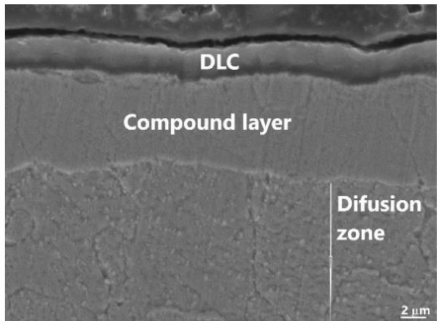
Figure 3. Cross-section of the ground specimen after plasma nitriding and DLC